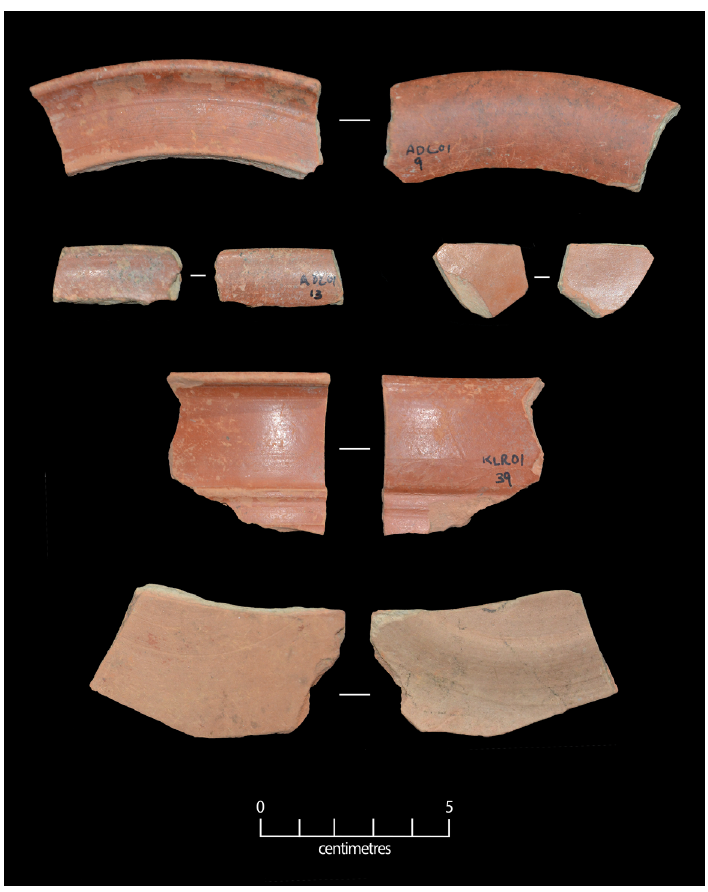
Figure 28: External and internal surfaces of various Class 9 variant 1